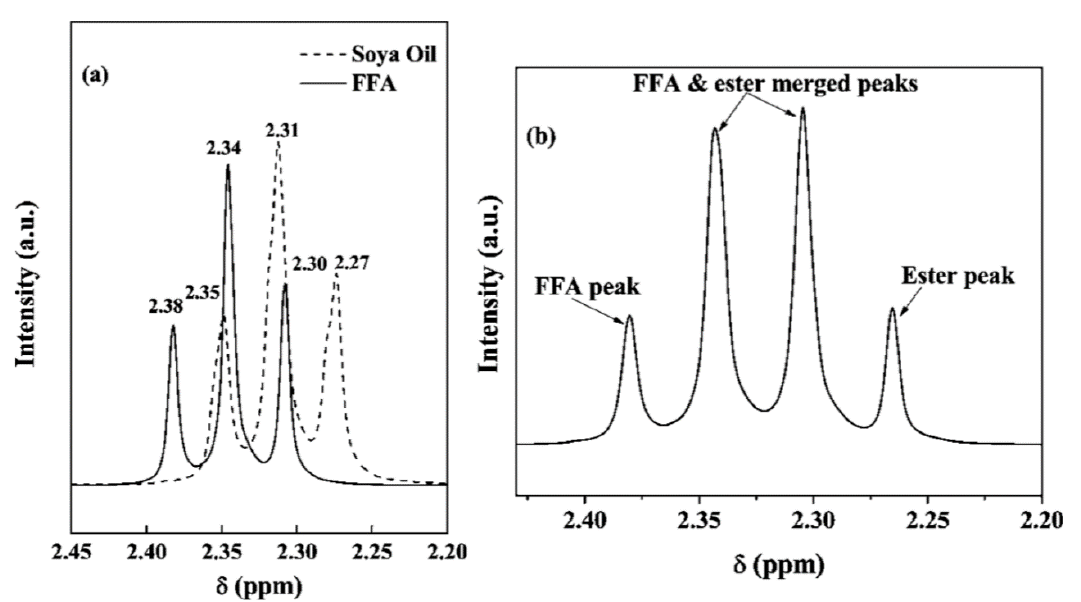
Figure 2. 1 H NMR spectrum of α-CH 2 region of ( a ) soybean oil and the free fatty acid (FFA) oleic acid, and ( b ) a mixture of oleic acid and its methyl ester. The sample for 1 H NMR was prepared by dissolving 20–25 mg in 0.6 mL of CDCl 3 . The spectrum was acquired on a Bruker AV 200 MHz spectrometer at 298 K, using 30 scans, with an acquisition time of 3.9 s, a 30 ◦ flip angle and a relaxation delay of 1 s. Reprinted with permission from Energy & Fuels , Vol. 23, J. K. Satyarthi, D. Srinivas, P. Ratnasamy, “Estimation of Free Fatty Acid Content in Oils, Fats, and Biodiesel by 1 H NMR Spectroscopy” (pages 2273–2277). Copyright (2009) American Chemical